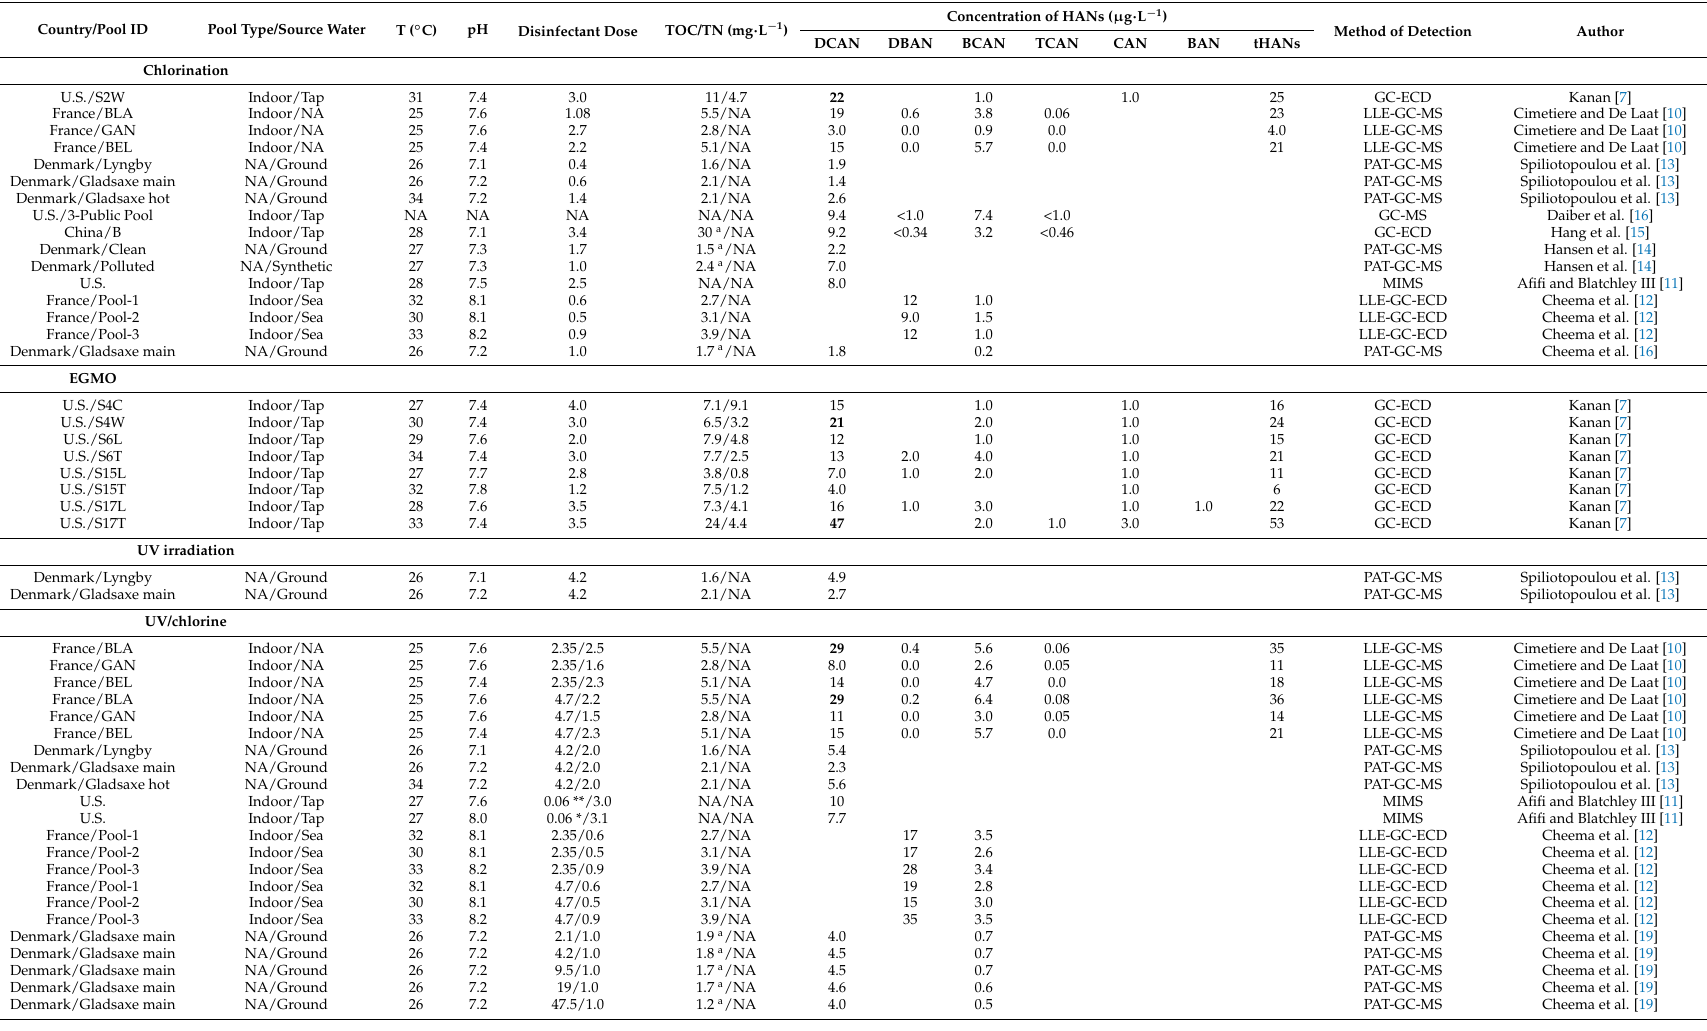
Table A5. Concentration of HANs with different disinfection